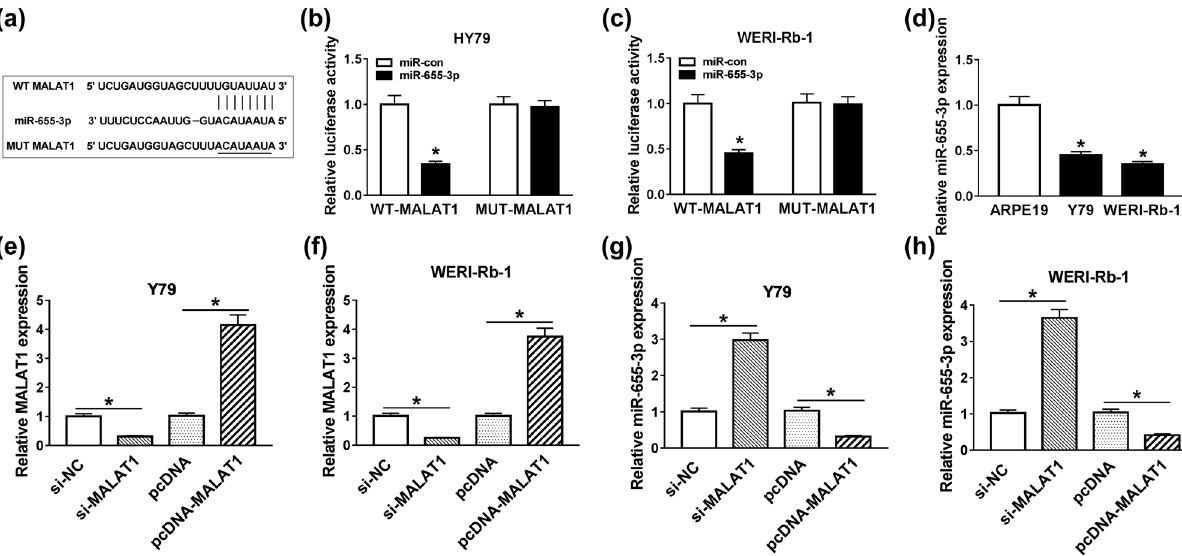
Figure 3: MALAT1 negatively interacted with miR - 655 - 3p in Y79 and WERI - Rb - 1 cells. ( a ) The fragment of MALAT1 containing the putative or mutant miR - 655 - 3p binding sites. ( b and c ) WT - MALAT1 or MUT - MALAT1 reporter plasmids and miR - con or miR - 655 - 3p were co - transfected into Y79 and WERI - Rb - 1 cells for 48 h. The luciferase activities were evaluated by dual - luciferase reporter assay. ( d ) The expression of miR - 655 - 3p in RB cells Y79 and WERI - Rb - 1 and retinal pigment epithelial cell line ARPE19 was tested by RT - qPCR. ( e – h ) Y79 and WERI - Rb - 1 cells were transfected with si - NC, si - MALAT1, pcDNA, or pcDNA - MALAT1 for 24 h. ( e and f ) The expression of MALAT1 in the cells upon transfection was detected by RT - qPCR. ( g and h ) The expression of miR - 655 - 3p in Y79 and WERI - Rb - 1 cells upon transfection was detected via RT - qPCR. * P <